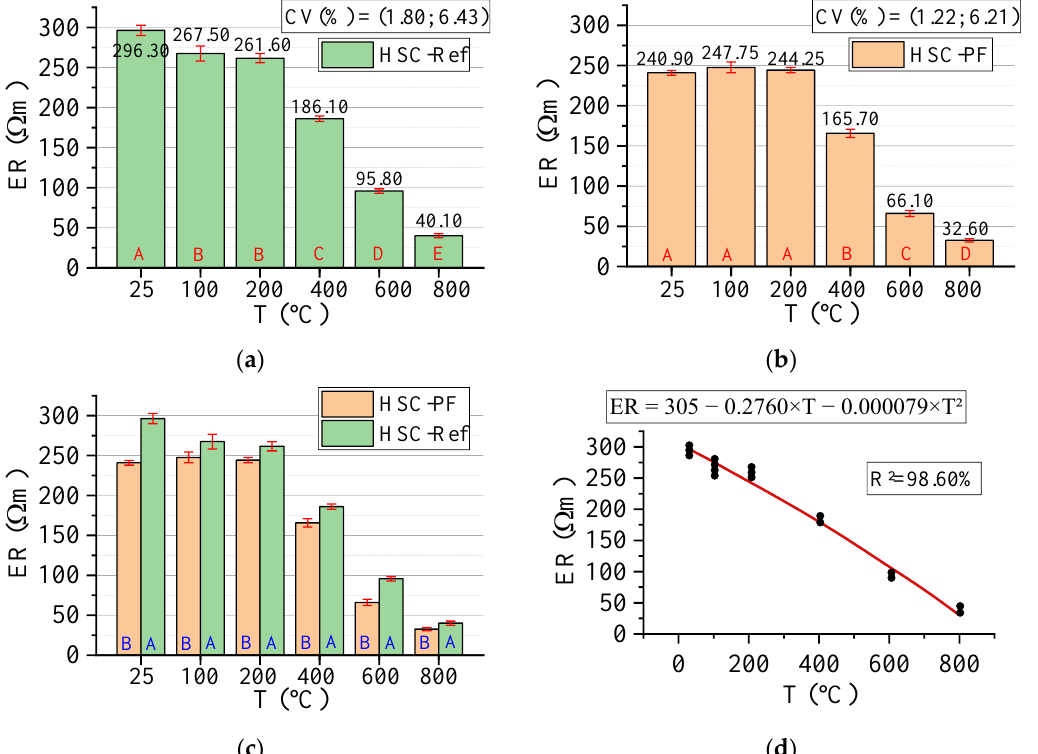
with and without the presence of synthetic fibers.